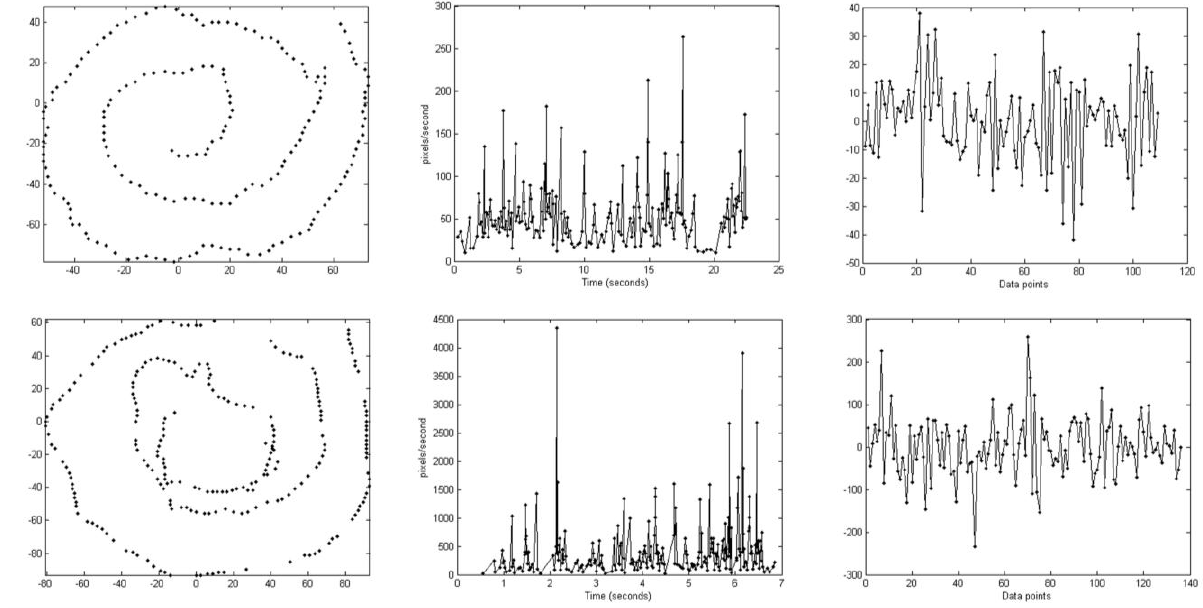
Figure 2. Two illustrative examples of spirals rated as bradykinesia ( upper row ) and dyskinesia ( lower row ) by the four raters. The first column shows the actual spiral drawings, the second shows drawing speed over the test trial and the third column shows the high-frequency wavelet coefficients of radial velocity within the frequency range 2.5–5 Hz. Note the different Y axis scales for the two cases. Mean visual ratings of the four raters for the two spirals were as follows: “impairment” (bradykinesia = 4.75, dyskinesia = 7), “speed” (2.25, 0), “irregularity” (2, 2.75), and “hesitation” (1.5, 0.25). The spirals had the following feature values: mean drawing speed (bradykinesia = 55.8, dyskinesia = 289), standard deviation of wavelet coefficients (14.8, 69.3), Approximate Entropy of drawing speed (0.06, 0.52), and total symmetry (0.18,